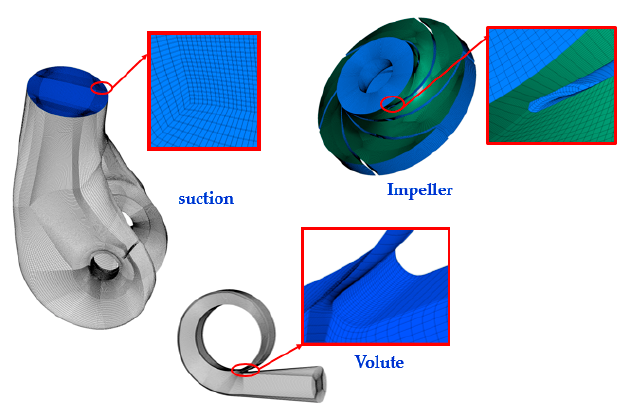
Figure 2. Mesh overview of the flow domains.